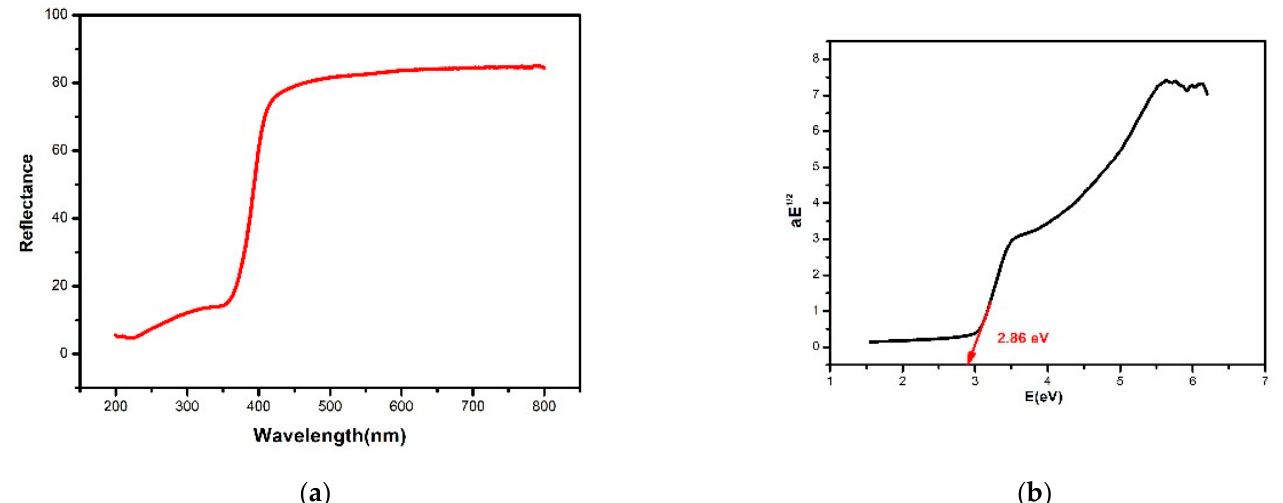
Figure 3. ( a ) Reflectance vs. wavelength plot; ( b ) Tauc plot of THB plotted using THB Kubelka–Munk function.